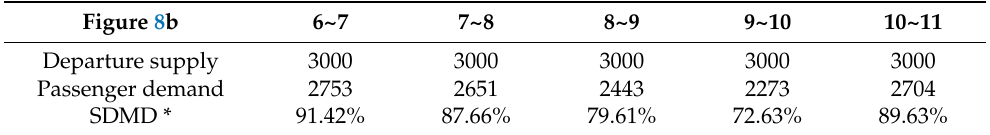
Table 13. Details of supply and demand matching degree of single-cycle timetable in scenario 3. Figure 8b